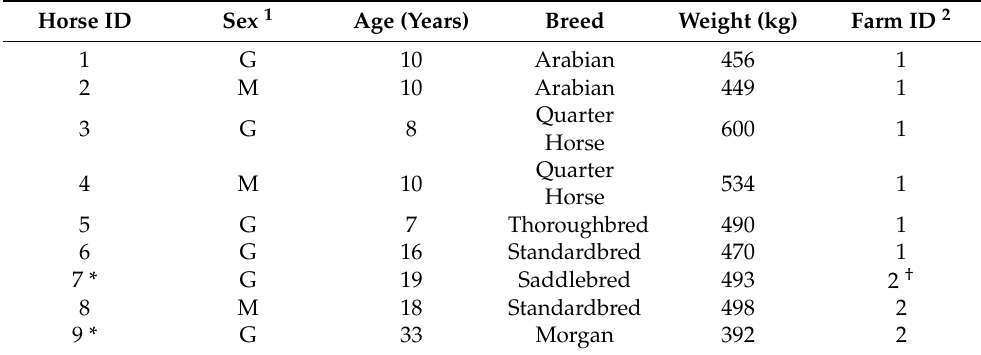
Table 1. Description of horse